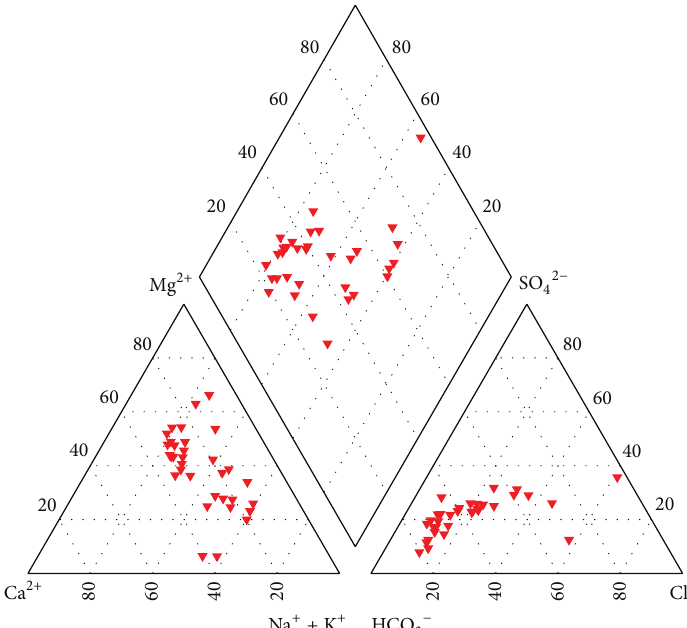
Figure 5: Piper diagram of confined water drawn with AquaChem